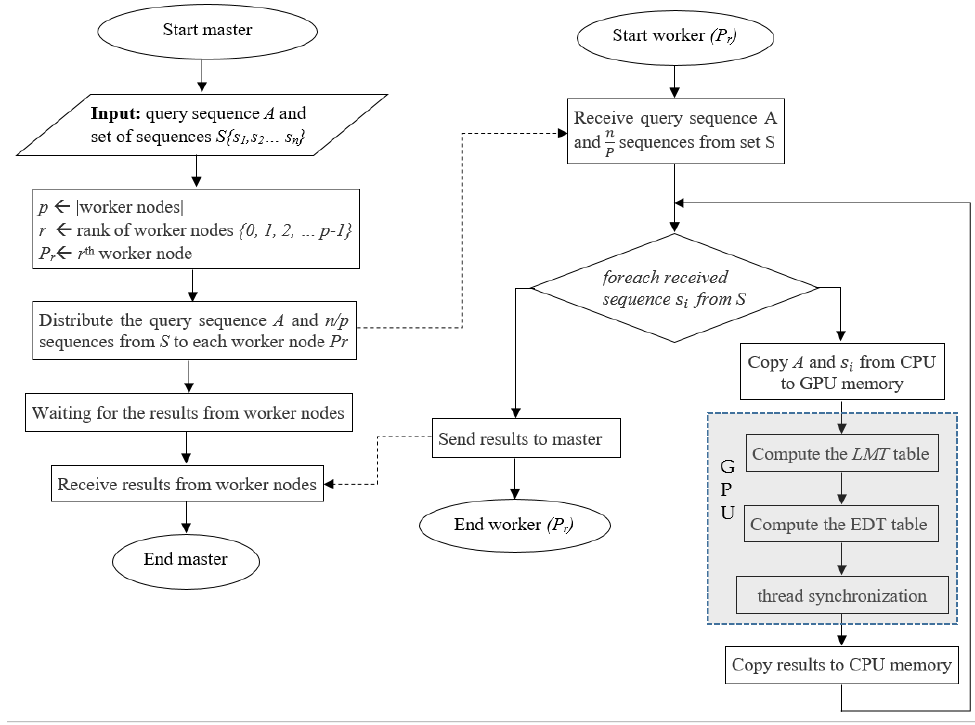
Figure 9. Flowchart of the hybrid approach. The shaded area shows the part of computation performed in parallel by GPU threads. The dotted lines show the communication between master and worker